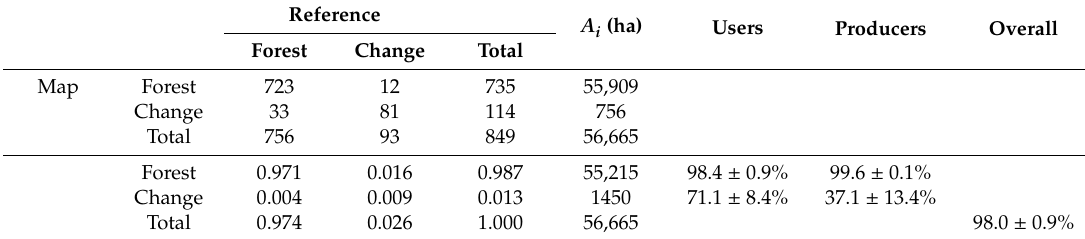
Table 4. Error matrix for Malawi, blind approach—2 orbits.